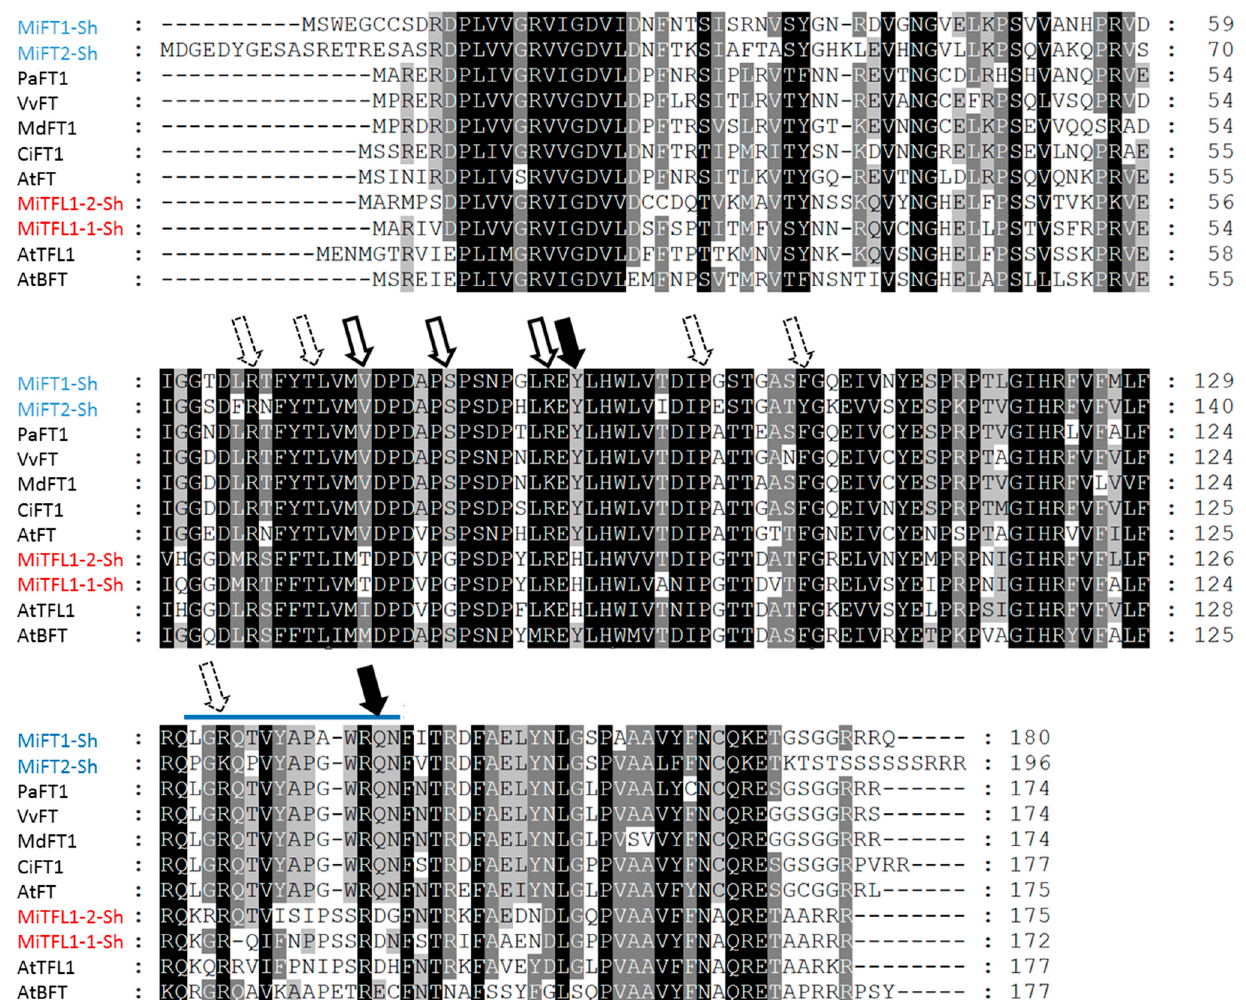
Figure 2. Amino acid sequence comparison and structural features of mango ‘Shelly’ cultivar MiFT1, MiFT2, MiTFL1-1 and MiTFL1-2. Comparison of the deduced amino acid sequences of the four MiFT/TFL1 genes isolated from ‘Shelly’ with representative FT and TFL1 proteins from: avocado ( Persea americana ) Pa FT (accession no. [ac]: AIG92770.1), grape ( Vitis vinifera ) Vv FT1 (ac: ABL98120.1), citrus ( Citrus unshiu ) Ci FT1 (ac: BAA77836.1), apple ( Malus x domestica ) Md FT (ac: ACL98164.1) and Arabidopsis ( Arabidopsis thaliana ) At FT (ac: BAA77838.1); and with BFT and TFL1 proteins from Arabidopsis , At TFL1 (ac: AED90661.1) and At BFT (ac: Q9FIT4.1). Residue shading in black, dark gray and light gray indicates 100%, 75%, and 50% amino acid similarity, respectively. Dashed lines indicate gaps introduced to achieve maximum alignment. The two key FT amino acid residues corresponding to At FT Tyr-85 and Gln-140 in At FT1 are indicated with black arrows. The three amino acid residues corresponding to Val-70, Ser-76 and Arg-83 in At FT, which have been suggested to play an essential role in regulating FT transport, are indicated with white arrows. The five conserved amino acid residues corresponding to Arg-62, The-66, Pro-94, Fhe-101 and Arg-130 in At FT, which have been suggested to be required for the 14-3-3 interaction, are indicated with dashed white arrows. The conserved amino acid sequence LGRQTVYAPGWRQN, which distinguishes FT from TFL1 and/or BFT, is overlined in blue.